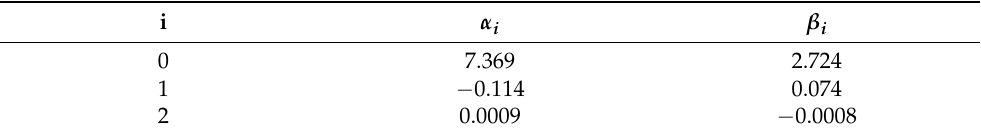
Figure 6. Heat pump EST-COP curve for heating and cooling operations. Table 5. Comparison of the heat pump performance data for the ASHP-PDHP simulation.